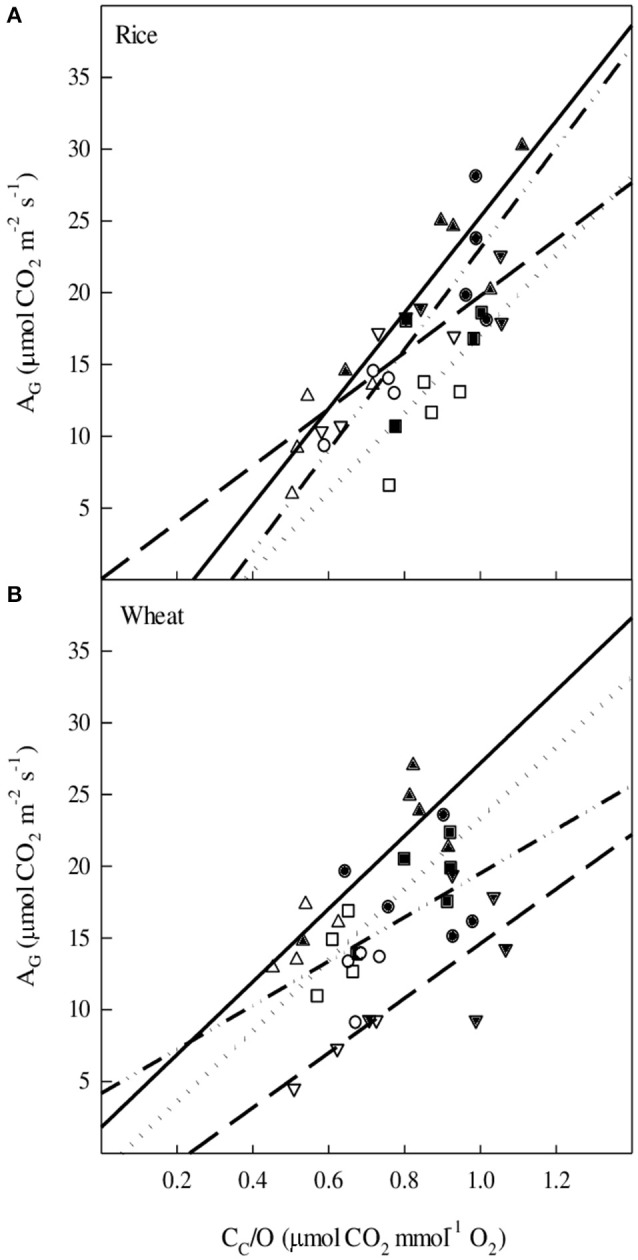
The relationship between: the gross photosynthesis rate (AG) and the relative concentrations of CO2 and O2 (Cc/O) for (A) rice and (B) wheat. Symbols, treatments and lines as follows: ▴ CT-WW-25°C, ▵ CT-WD-25°C, solid regression (); ▾ CT-WW-38°C, ▿ CT-WD-38°C, dashed regression (); ■ HT-WW-25°C, □ HT-WD-25°C, dotted regression (); • HT-WW-38°C, ° HT-WD-38°C, dashed-dotted regression (). In rice, solid regression R2 = 0.90 P < 0.001, dashed regression R2 = 0.69 P < 0.01, dotted regression R2 = 0.54 P < 0.05, and dashed-dotted regression R2 = 0.77 P < 0.001. In wheat, solid regression R2 = 0.79 P < 0.001, dashed regression R2 = 0.60 P < 0.01, and dotted regression R2 = 0.65 P < 0.01.